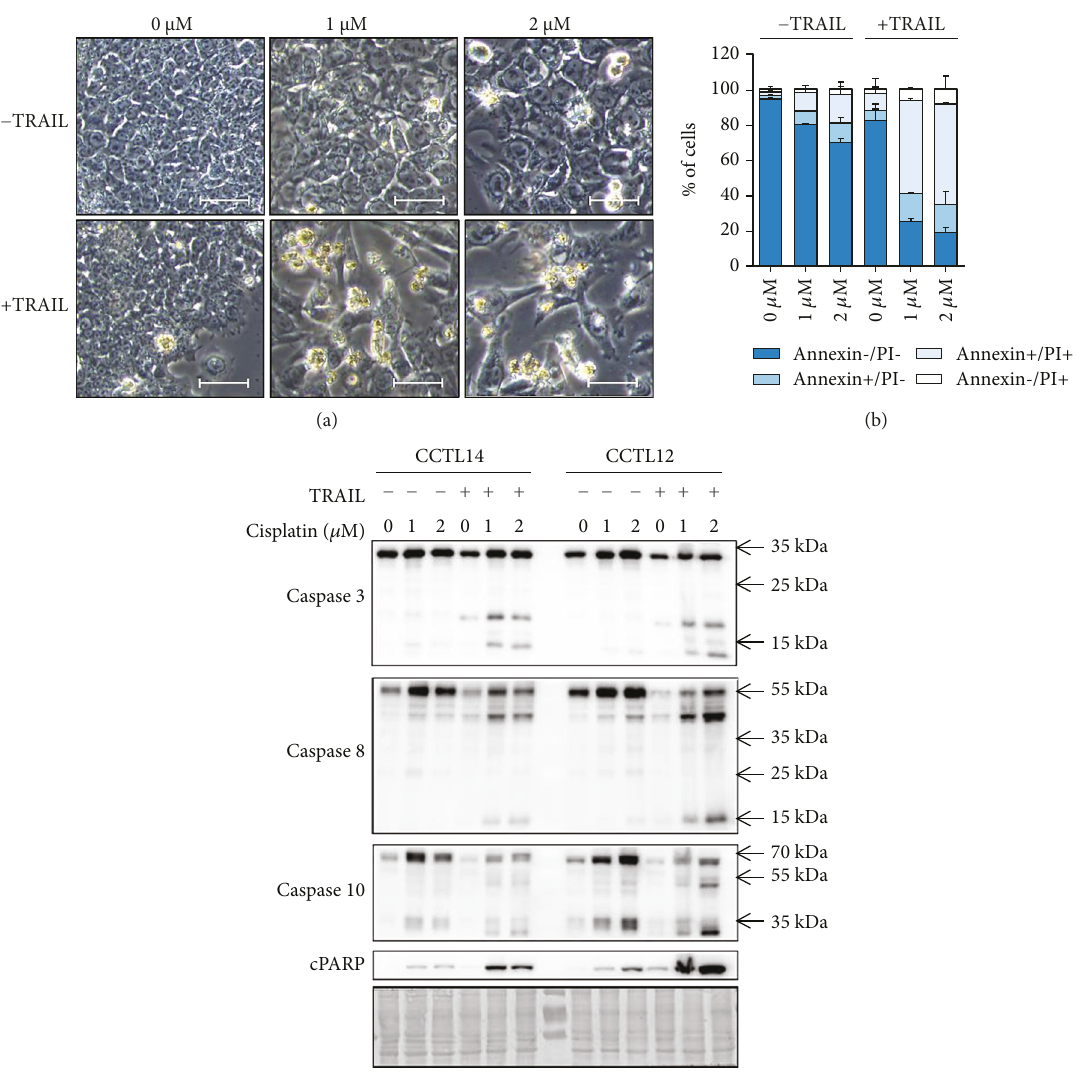
Figure 2: Cisplatin sensitizes hESC towards TRAIL-induced apoptosis. Cells were cultured in the presence of 1 μ M and 2 μ M doses of cisplatin for 24 hours and then they were treated with recombinant human TRAIL (200ng/ml) for 24 hours. (a) Morphology of hESC upon the given treatments as observed by light microscopy (10x, bar 50 μ m). Both CCTL12 and CCTL14 lines of hESC were used ( n = 1 for CCTL12; n = 3 for CCTL14); a representative picture is shown. (b) Graphs showing cell death incidence as determined by fl ow cytometric analysis after double staining with Annexin-V and propidium iodide. At least 10,000 cells were analyzed per sample. Living (Annexin-/PI-), apoptotic (Annexin+/PI-), necrotic (Annexin-/PI+), and secondary necrotic cells (Annexin+/PI+) are reported as a percentage of the total cell count. The CCTL14 line of hESC was used ( n = 2 ). (c) Activation of the caspase cascade and PARP cleavage upon the given treatments